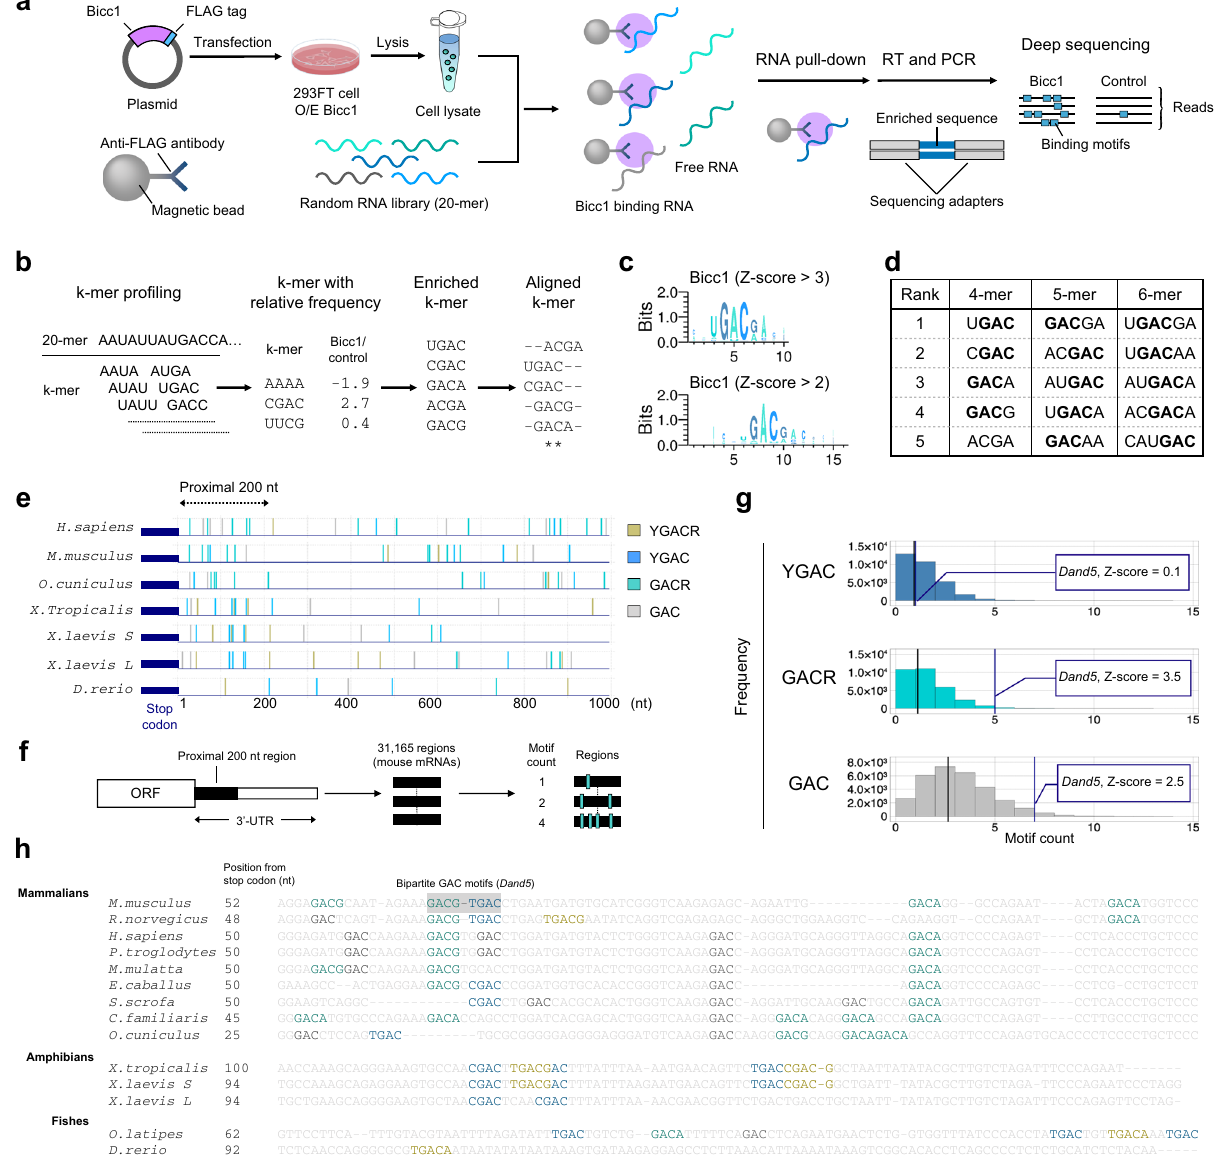
Fig. 6 Screen for Bicc1-binding motifs in RNA. a Schematic representation of RNA Bind-n-Seq (RBNS), which determines RNA motifs enriched by target proteins with the use of a random RNA sequence library. 293FT cells were transfected with a plasmid for overexpression (O/E) of FLAG-tagged Bicc1. Cell lysates containing the Bicc1-FLAG protein were then mixed with a random RNA sequence library, and resulting RNA-protein complexes were isolated by immunoprecipitation with magnetic bead – conjugated antibodies to FLAG. Finally, the isolated RNA sequences were converted to a DNA library by RT-PCR for deep sequencing. b Analysis of the RBNS data set. The number of each k-mer (where k = 4, 5, or 6) RNA sequence was compared between cells transfected with the Bicc1-FLAG expression plasmid and those subjected to mock transfection (control). c Motif logos generated from aligned hexamers that were enriched by Bicc1-FLAG. d 4-mer, 5-mer, and 6-mer sequences ranked by their relative frequencies in Bicc1-FLAG versus control RBNS data. e Maps of GAC-containing motifs in the 3 ′ -UTR of Dand5 mRNAs for the indicated species. f Schematic representation of metagene analysis for the 200- nucleotide proximal region of the 3 ′ -UTR of mouse mRNAs. A total of 31,165 regions extracted from mouse genes (mm10) was searched with the indicated target motifs. g Histogram of motif frequency revealed by metagene analysis. The vertical lines indicate the averaged frequency of each target motif (black) and the frequency of each target motif in the 200-nucleotide proximal region of the 3 ′ -UTR of Dand5 mRNA (blue), respectively. h Multiple sequence alignment of a conserved segment within the proximal 200 nucleotides of mammalian, amphibian, and fi sh Dand5 3 ′ -UTRs . Colors highlight GAC motifs. degradation of the Dand5 mRNA in response to Pkd2 stimu- lation by leftward fl uid fl ow. Bicc1 binds to various target mRNAs, but no consensus motif